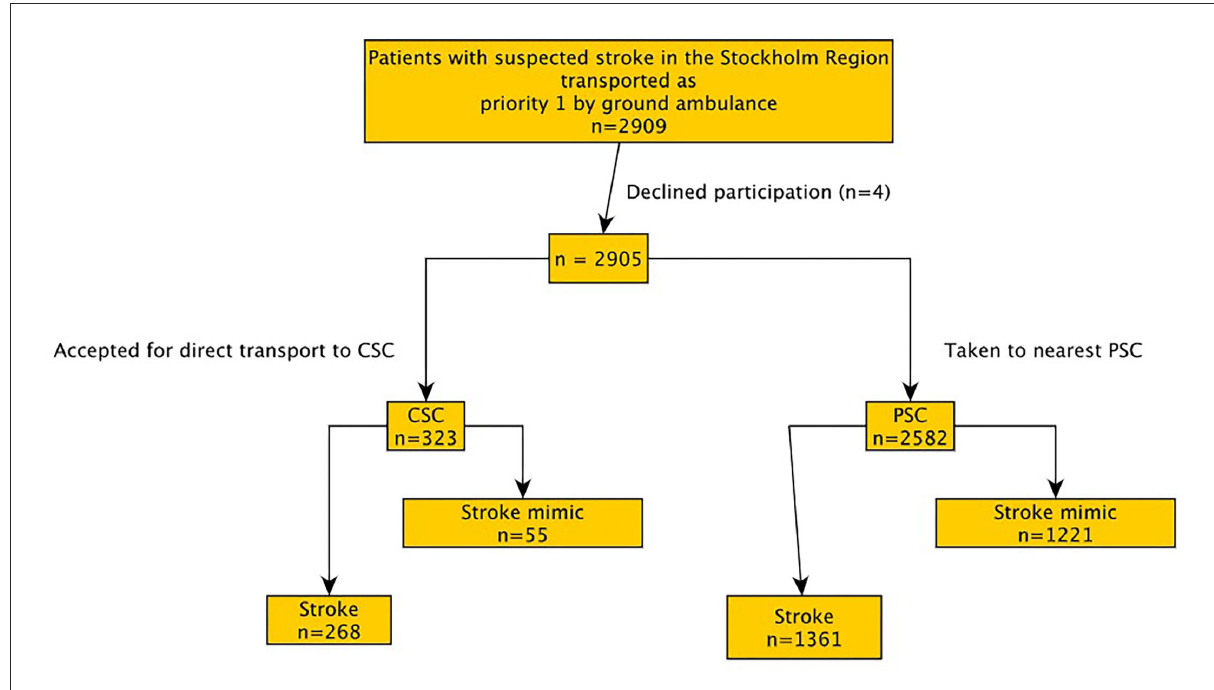
FIGURE2 Patient distribution per study